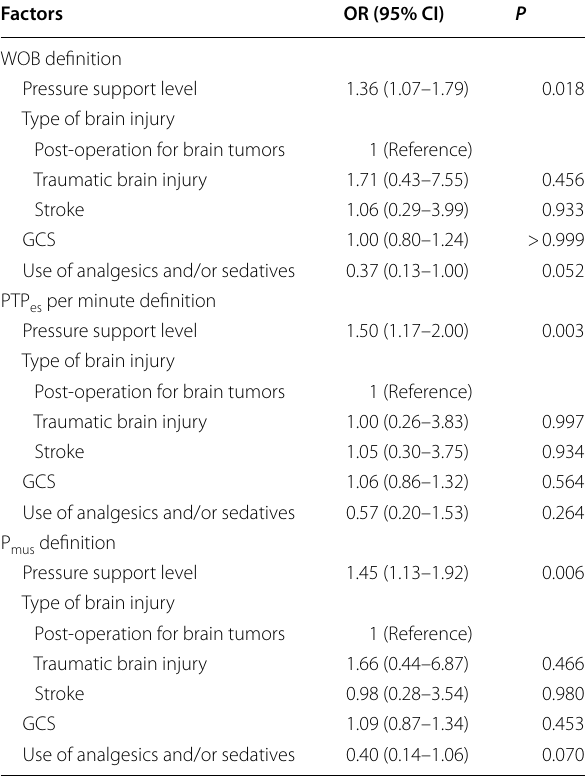
Table 4 Potential factors associated with low inspiratory